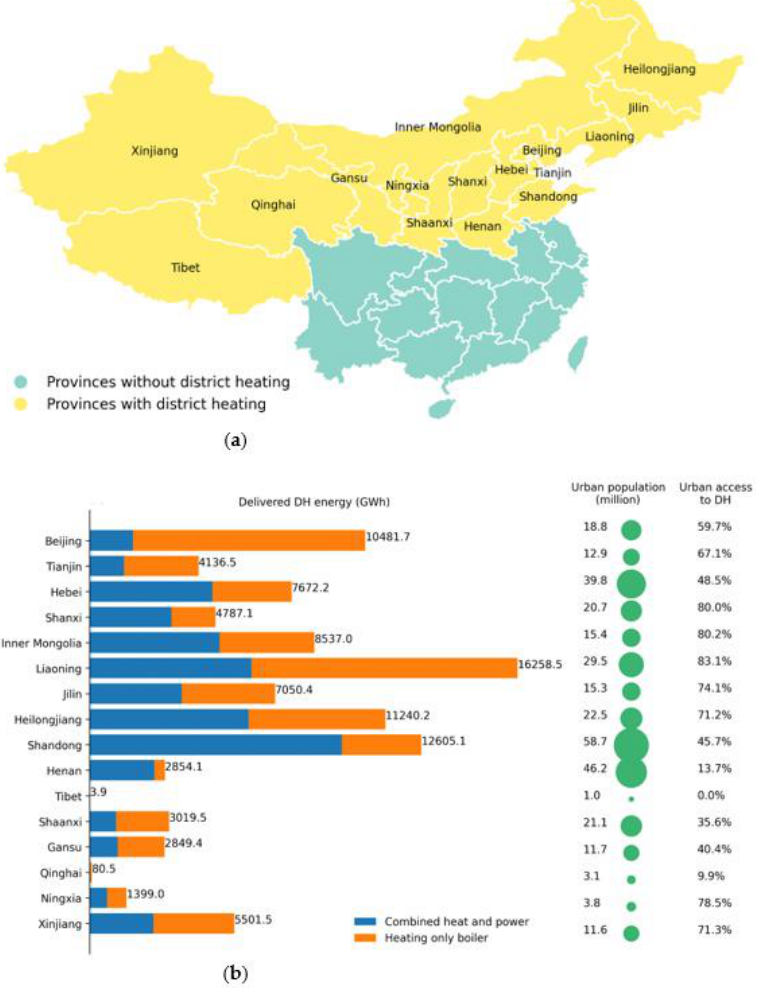
Figure 3. ( a ) DH supply in China; ( b ) delivered DH energy in north China for each province and urban population and urban access to DH in north China for each province (data compiled from [48]).